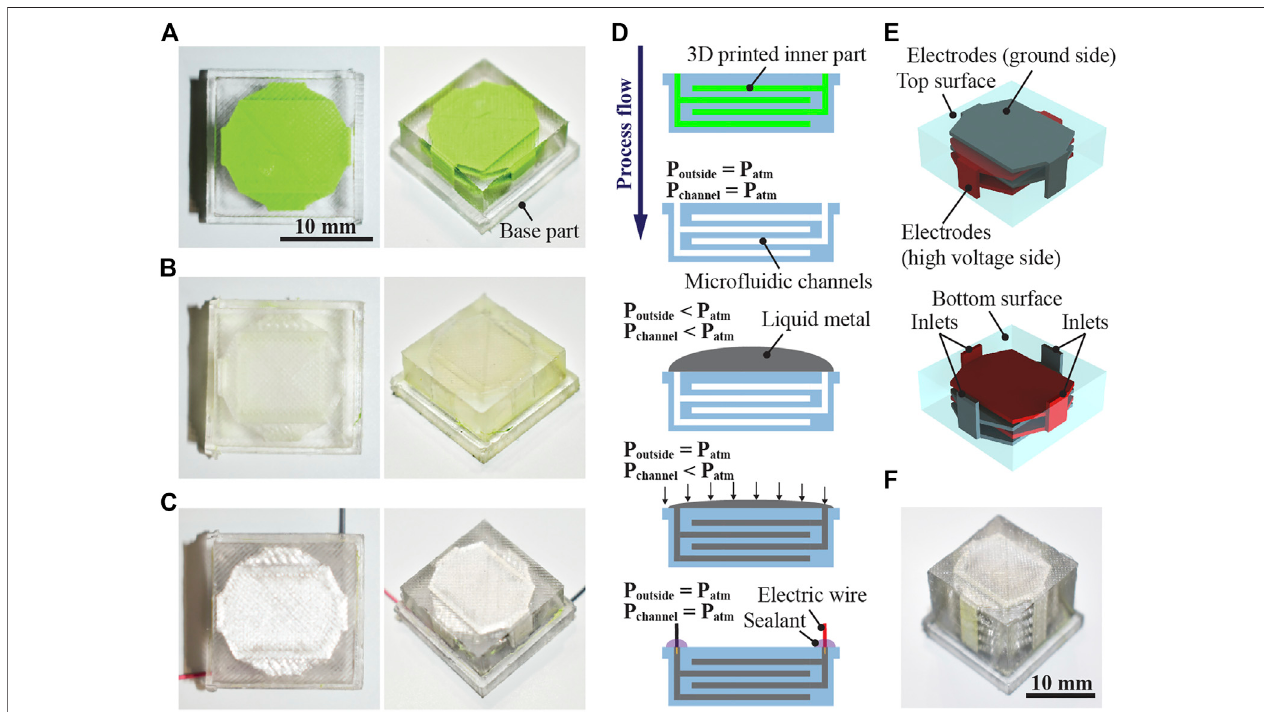
FIGURE 1| Monolithicstacked DEAs fabricated in this study, comprising a silicone elastomer matrix and liquid metal. (A) Elastomeric matrix with a 3D printed part that has an electrode shape. (B) Elastomeric matrix after dissolution of the inner part, wherein empty channels remain. (C) Elastomeric matrix after injection of the liquid metalintotheemptychannelsandcompletionofthewiring. (D) Process fl owofthefabrication.The3Dprintedinner partisdissolved, whichbecomesanemptychannel that has an electrode shape. The liquid metal is then injected into the micro fl uidic channels by the pressure difference between the channel and the outside of the elastomeric matrix. (E) Structural viewofthe actuator. The electrodes are aligned such thatopposingpolarity alternately appearswhen subjected totheapplied voltage. (F) Monolithic stacked DEA with 10 electrodes.